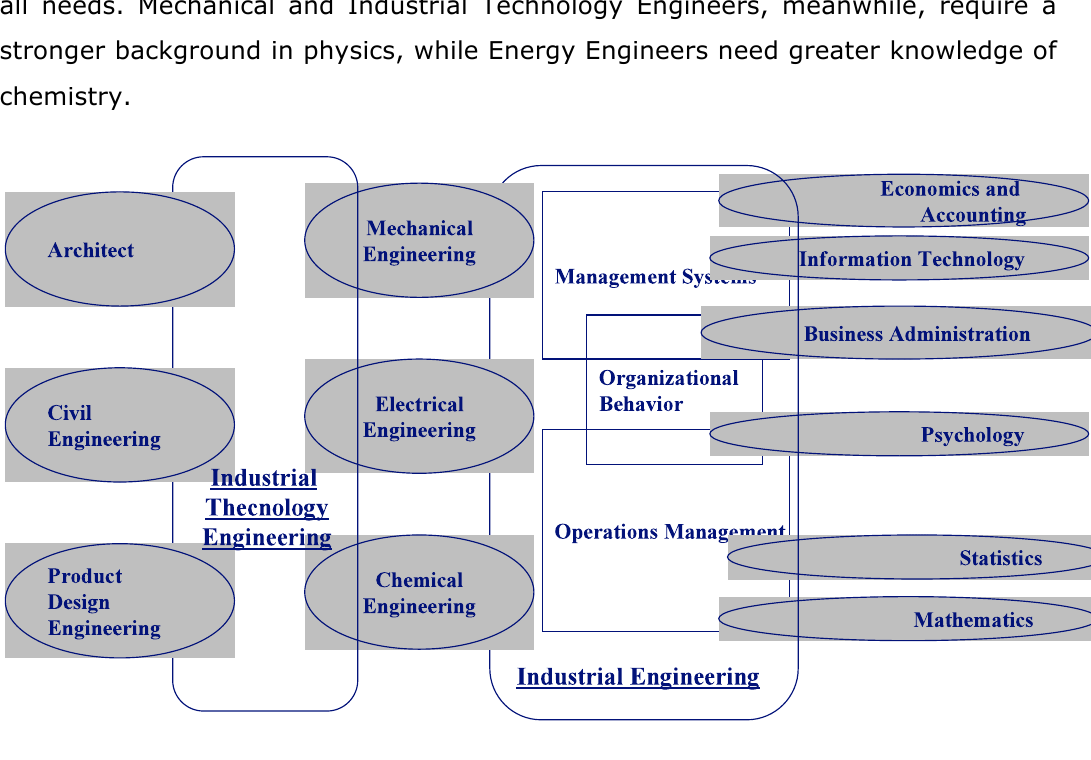
Figure 1. “Relationships between